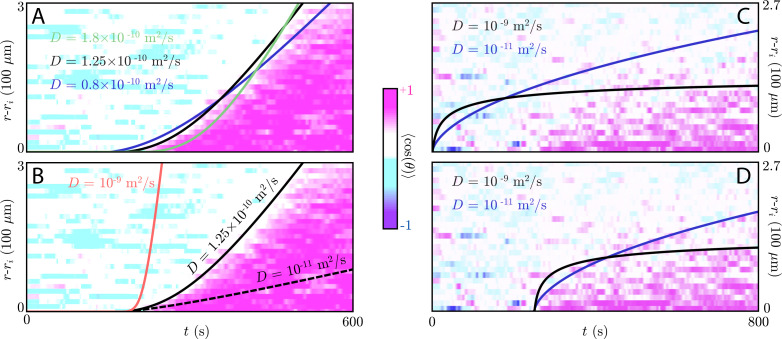
Wavefront fitting of the simple diffusion and relay models.(A) Plot showing the information waves for various choices of diffusion constant (black) overlaid on the experimental chemotactic index data from Reátegui et al., 2017 (color plot). Here, we take ri=100 µm, although the target in the experiment is a smaller, oblong object. The size of the target has no effect on the convex shape of the information wave front. The black line is reproduced from the main text and has D=1.25×10-10 m2/s and asymptotic wave speed v≈1.7 µm/s (the threshold concentration is Cth/a⁢ρ=2/π⁢v). This diffusion constant is consistent with a small molecule like LTB4, and the resulting information wave dynamics can be made to fit the information wave front – both the initiation time of ≈200 s and the transient dynamics. Other choices of parameters (green: D=1.8×10-10 m2/s, v≈2.3 µm/s, navy: D=0.8×10-10 m2/s, v≈1.3 µm/s) give information wave fronts that are also roughly consistent with the experimental data. (B) However, with a much larger (D=10-9 m2/s, red) or smaller (D=10-11 m2/s, dashed) diffusion constant, an information wave with the correct initiation time does not have the correct transient dynamics. The wave speeds for these larger and smaller diffusion constants are, respectively, v≈11 µm/s and v≈0.3 µm/s. (C) Simple diffusion models of various diffusion constants overlaid atop data from Reategui et al. in which the the same swarming assay as in A/B (but with a slightly smaller 80 µm target) was utilized but with neutrophils whose LTB4 receptors (BLT1/2) had been blocked. Here, we see a 250 s offset before the propagation of a slow-moving diffusive front. A simple diffusive model does not capture this offset well, but does accurately capture the concave shape of the front (which contrasts with the convex shape of the front propagated by a relay). (D) Same as in C but with a 250 s offset in the theoretical curves. These curves fit the observed chemotactic index dynamics fairly well.